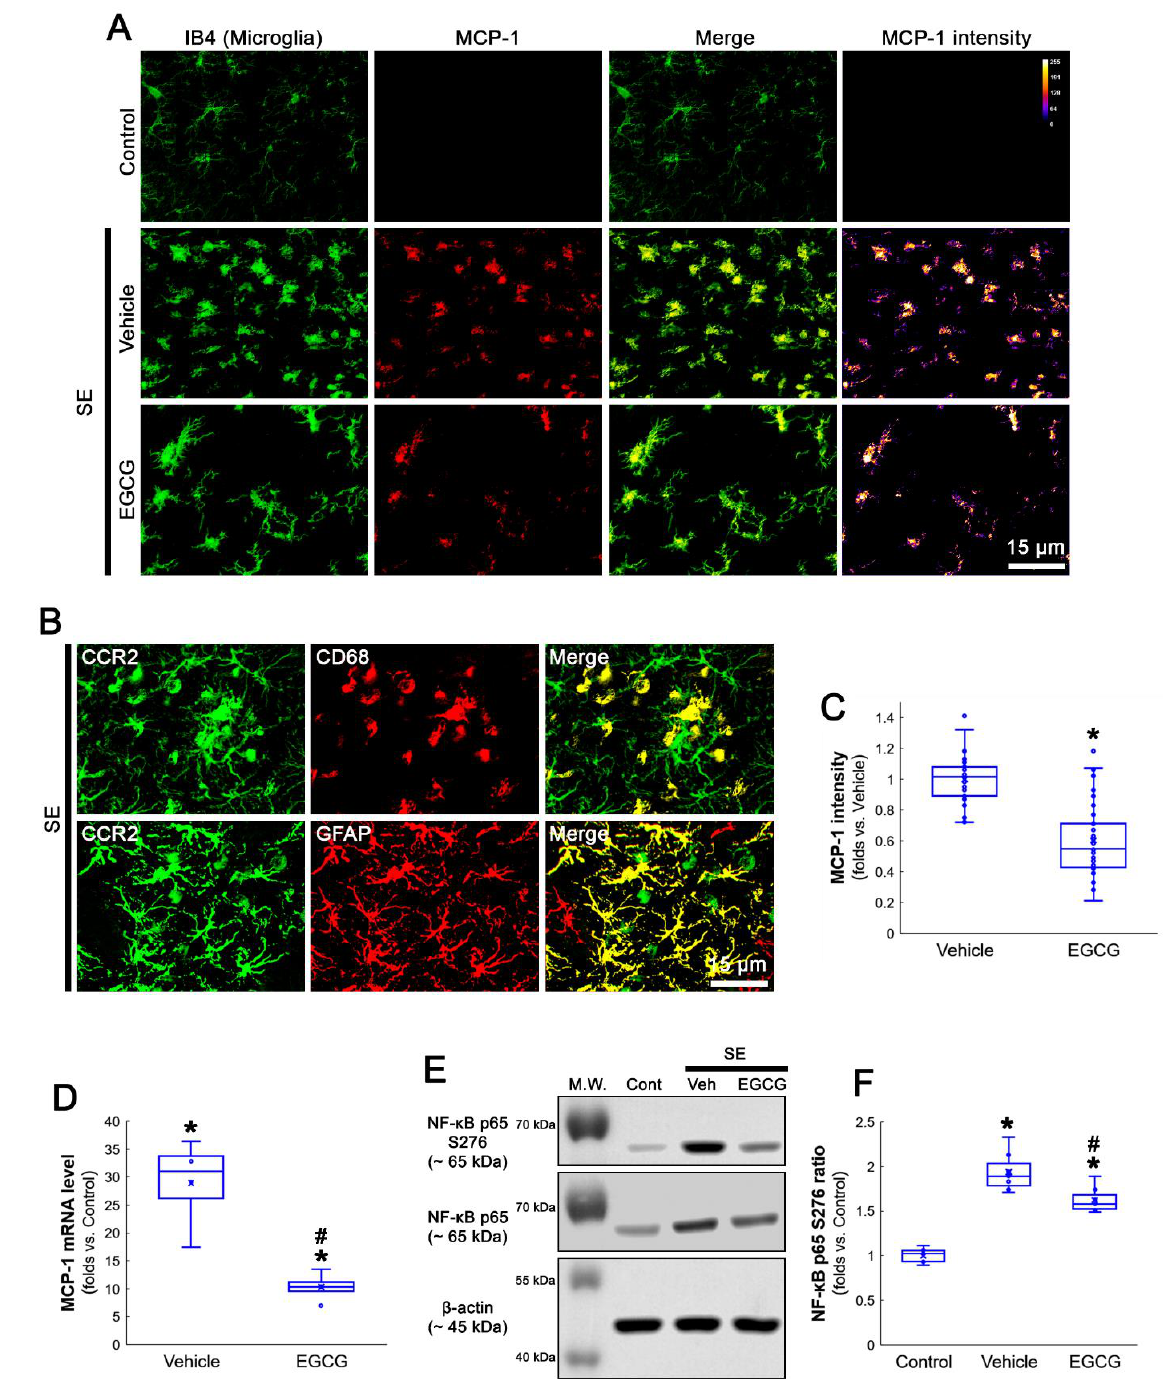
Figure 2. SE-induced microglial activation of MCP-1 induction and cellular localization of CCR2 (MCP-1 receptor). SE results in MCP-1 upregulation in activated microglia, which are ameliorated by EGCG. In addition, CCR2 expression is detected in infiltrating monocytes and astrocytes following SE. ( A ) Representative photos of microglia (IB4), MCP-1 expression and MCP-1 intensity in the FPC. ( B ) Representative photos of cellular localization of CCR2 in monocyte and astrocytes. ( C ) Quantification of the MCP-1 intensity in microglia. * p < 0.05 vs. vehicle ( n = 40 cells in 7 rats, respectively). ( D ) Quantification of the MCP-1 mRNA in the hippocampus. * ,# p < 0.05 vs. control and vehicle ( n = 4 rats, respectively). ( E , F ) Representative Western blot data for NF-κB p65 S276 phosphorylation and quantification of the NF-κB p65 S276 ratio in the hippocampus. * ,# p < 0.05 vs. control animal and vehicle, respectively ( n = 7 rats, respectively).